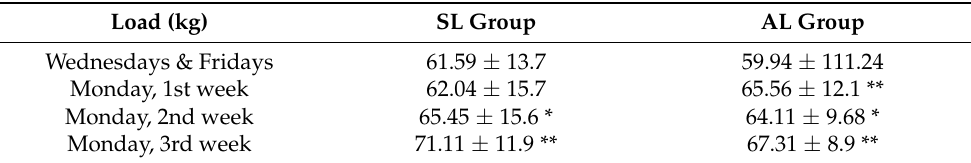
Table 3. Training load linked to 1.2 ms − 1 of the mean propulsive velocity (MPV) throughout the training period.